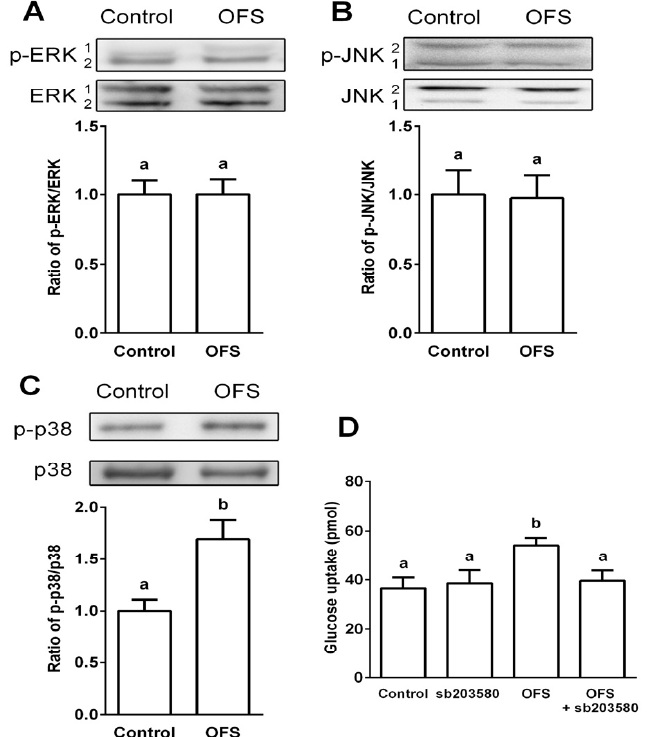
Figure 3. Effects of OFS on activation of MAPKs in L6 myoblasts. Western blot and densitometric results of the phosphorylation of ERK1/2 ( A ), JNK1/2 ( B ), and p38 ( C ). Effect of p38 inhibitor (sb203580) on glucose uptake ( D ). Cells were treated with OFS (100 µ g/mL), and total cell lysates were used to determine the phosphorylation levels of MAPKs by Western blotting. Each value is the mean ± SE ( n = 3). The bars with a different letter are significantly different from each other at the level of p < 0.05.